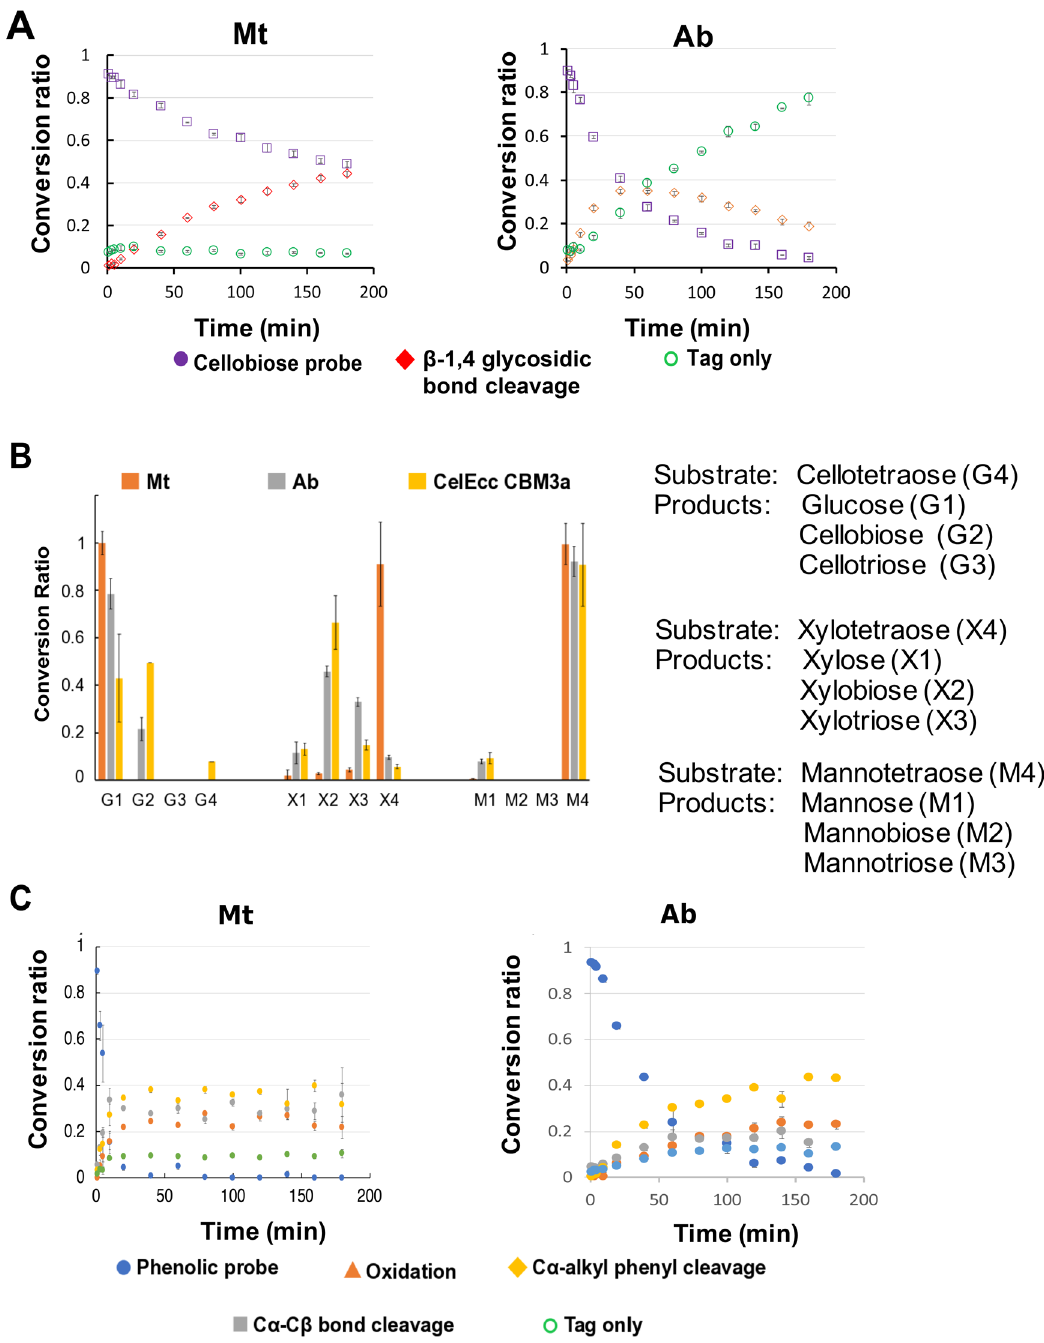
Figure 2. Independent analysis of glycoside hydrolase and lignin modifying enzyme activities Conversion of ( A ) GH probe (n = 3) and ( C ) LME probe (n = 3 ) . For both assays, e nzyme loading concentrations were 0.74 μg and 0.15 μg per 0.83 mM probe for Mt and Ab, respectively. The conversion ratio is expressed as the relative intensity of product and substrate peaks. ( B ) Conversion of oxime-NIMS-tagged oligosaccharides (n = 3). Enzyme loading concentrations were 1.4 μg and 0.3 μg per 1 mM xylotetraose or cellotetraose for Mt and Ab, respectively. The conversion ratio is expressed as the mass ratio of products, determined by normalization to C13 internal